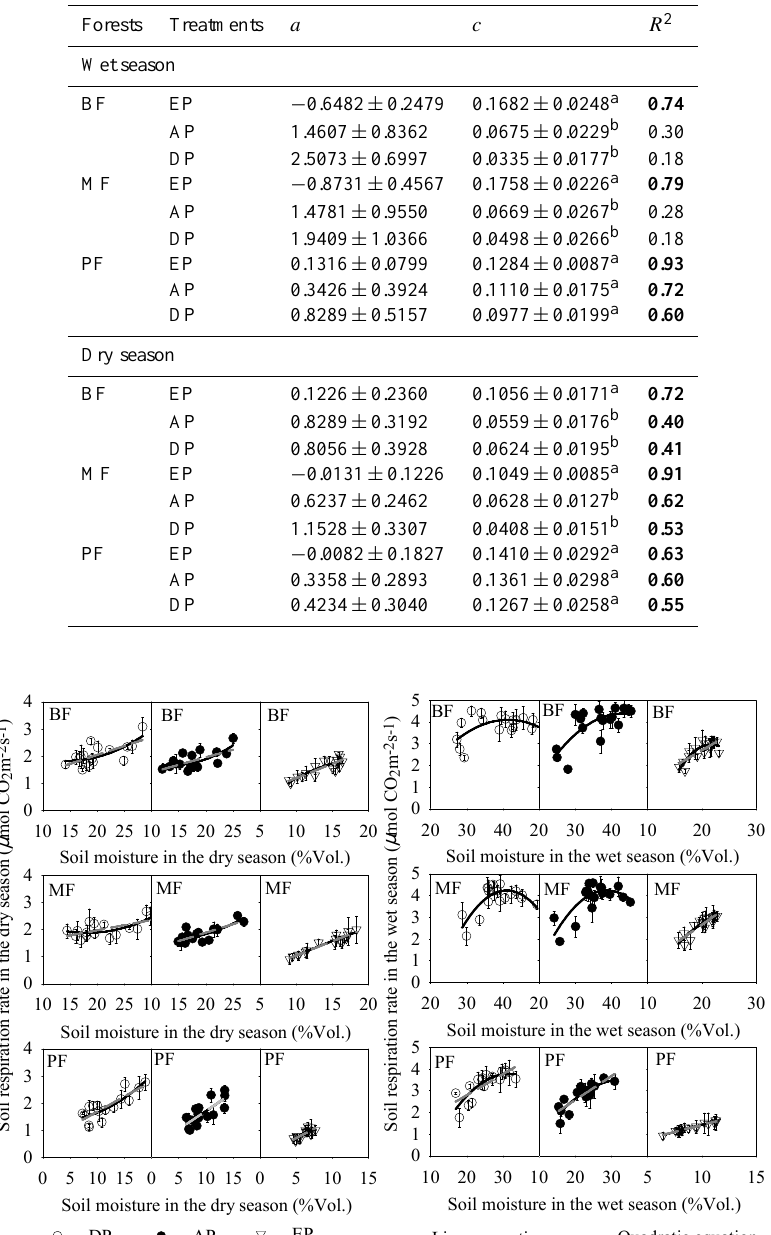
Table A2. Relationships of soil respiration ( R , µmolCO 2 m − 2 s − 1 ) and soil moisture of the top 5cm soil layer ( M , %vol.) using a linear regression equation ( R = a + cM , where parameter a is intercept, basal soil respiration when M = 0; and c is slope of regression representing the soil moisture sensitivity of soil respiration) (parameter estimate ± standard error) under different seasons and precipitation treatments at the DNR forests. The treatments are as follows: precipitation exclusion (EP), ambient precipitation (AP), and double precipitation (DP). The forests are as follows: broadleaf forest (BF), mixed forest (MF), and pine forest (PF). R 2 is the coefficient of determination. Numbers in bold indicate the level of function fitting is significant ( p < 0 . 05). Different superscripted letters in each forest site within a column denote significant difference ( p < 0 . 05) among precipitation treatments.